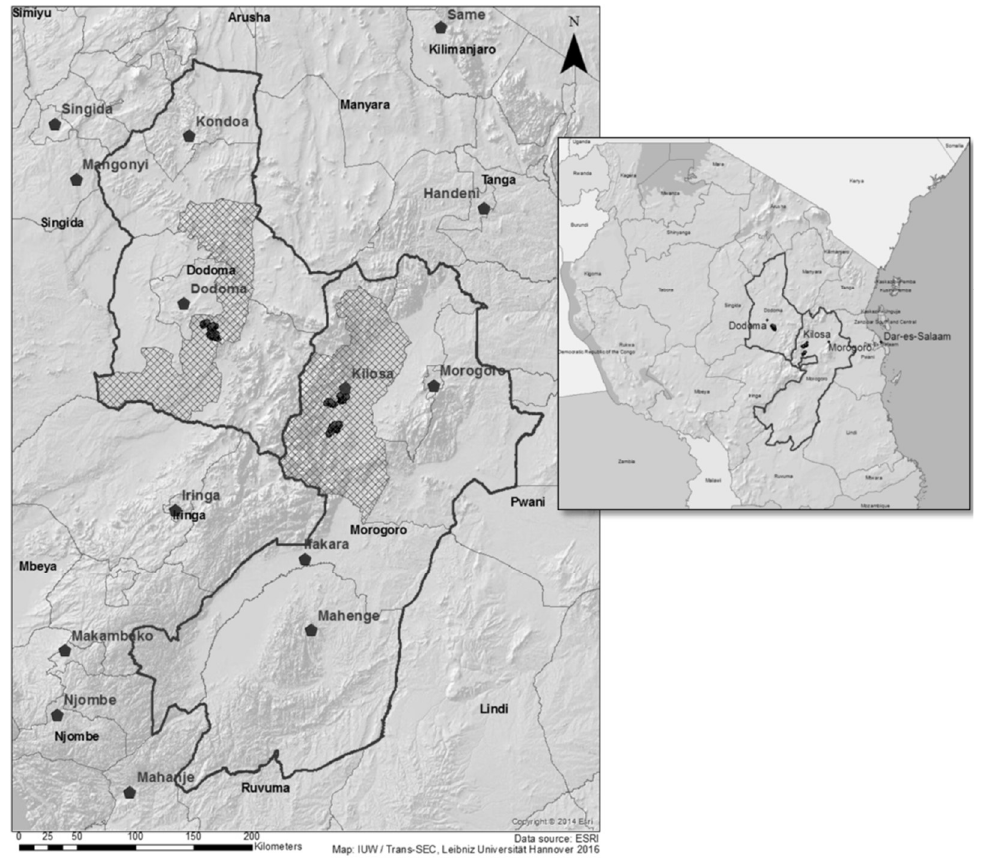
Table 1. Summary of main characteristics of study area.